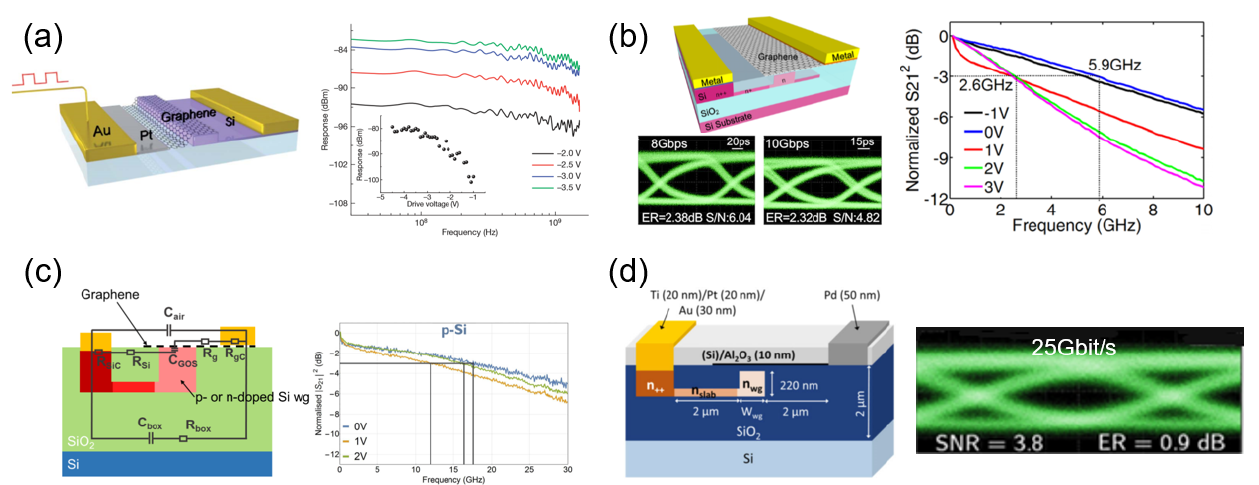
Figure 2. SLG − based EA modulator. ( a ) Left: a three-dimensional, schematic illustration of the first silicon-based SLG EA modulator. Right: the EO frequency response of the deviceunder different-drive voltage [26]. Reproduced from Ref. [26] with permission. ( b ) 3D schematic drawing of a single-layer graphene EA modulator (EAM) integrated on silicon waveguide with a flat surface. Measured S21 responses and optical eye diagrams (modulation speed: 8 Gbps and 10 Gbps) of the 50 µ m graphene EAM at different bias voltages [51]. Reproduced from Ref. [51] with permission. ( c ) Schematic cross-section of the graphene EAM indicating the equivalent electrical model and measured 3 dB- bandwidth up to 17.6 GHz for a 25 µ m-long p-Si device at 0 V, 1 V and 2 V [52]. Reproduced from Ref. [52] with permission. ( d ) Schematic 3D structure of the graphene-Si EA modulator with a encapsulate graphene through the passivation-first approach. Measured eye diagrams operating at 25 Gbps [36]. Reproduced from Ref. [36] with